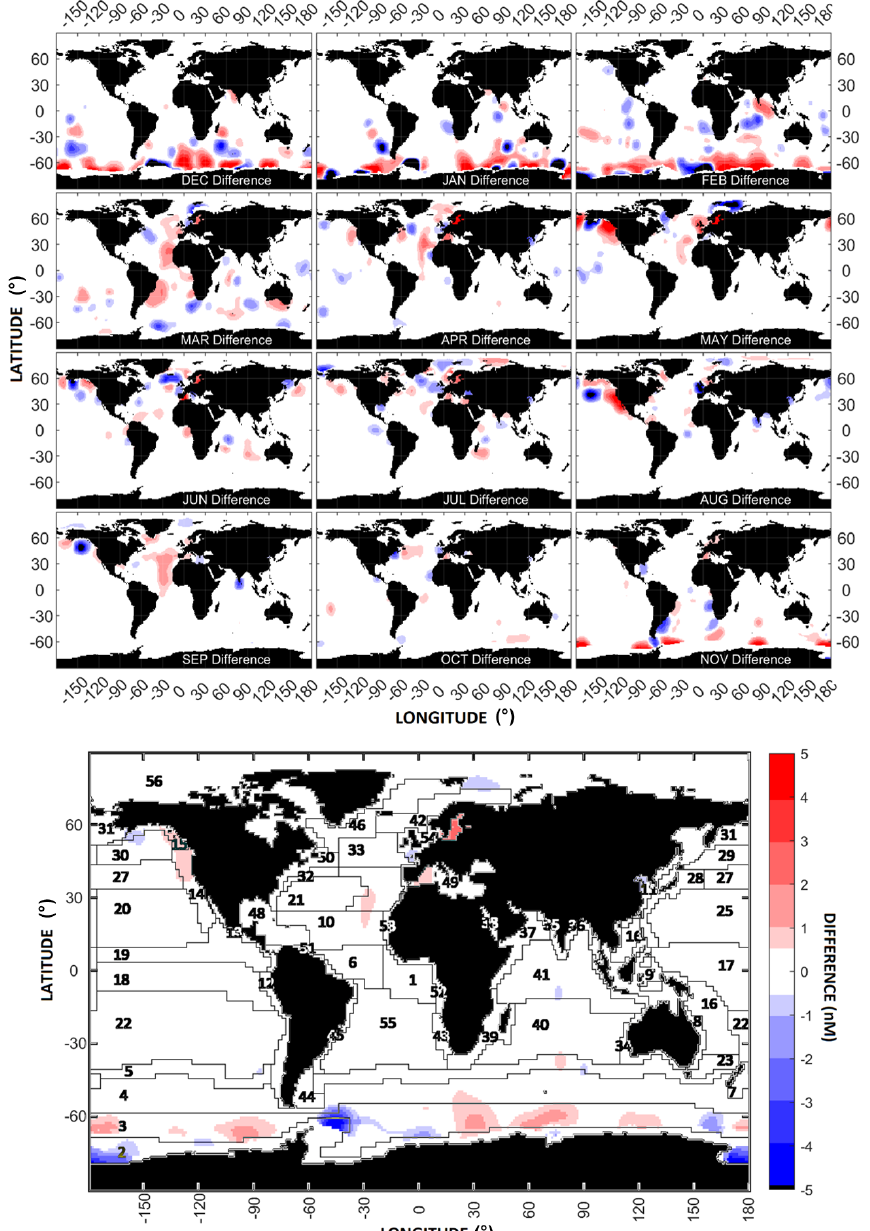
Figure 8. Differences in the DMS concentrations caused using variability length scales (VLS) instead of a fixed value for the radius of influence as used by L11 (555km) for the weighted average interpolation computation. (VLS –